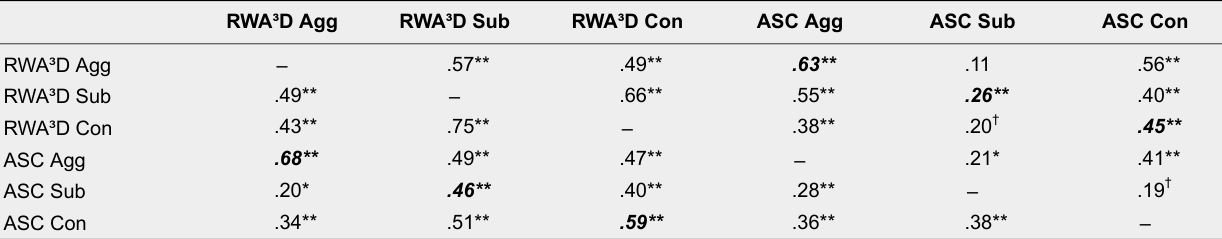
Multitrait-Multimethod Correlation Matrix for RWA³D Scale and ASC Scale, Sample 3 Students (Lower-Left) and Parents (Upper-Right).